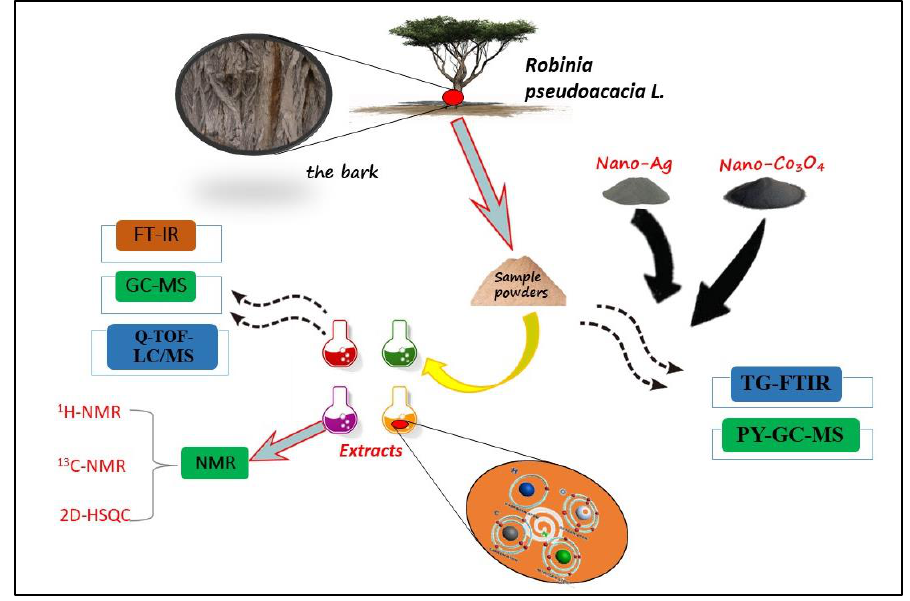
Figure 1. Experimental flow chart of RPB.